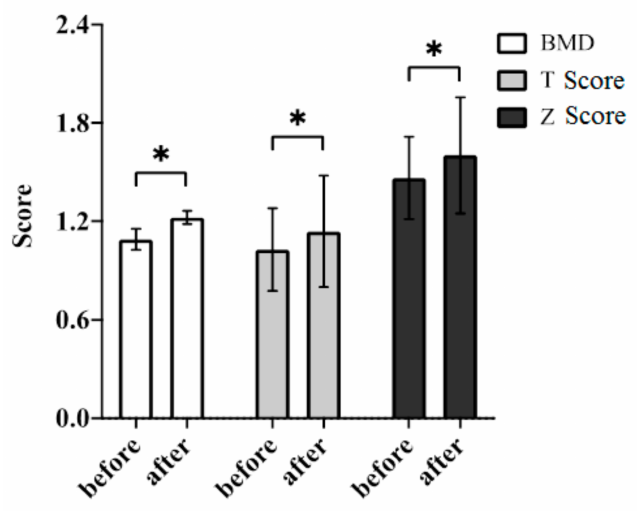
Figure 1. Therapeutic e ff ects of Cinacalcet on parameters of BMD in the whole study population. Note: * represents the p -value < 0.05 to compare the di ff erences between the two indicated groups by Mann–Whitney Rank Sum